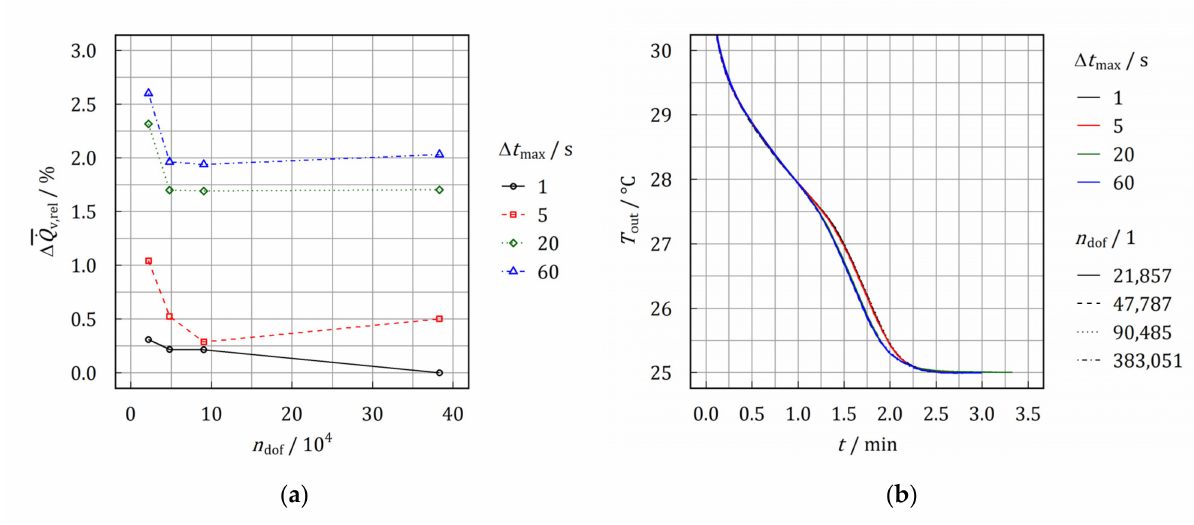
. Q v,rel of the mean volume specific thermal power ( a ) and outlet temperature of the Figure 12. Relative deviation ∆ HTF T out ( b